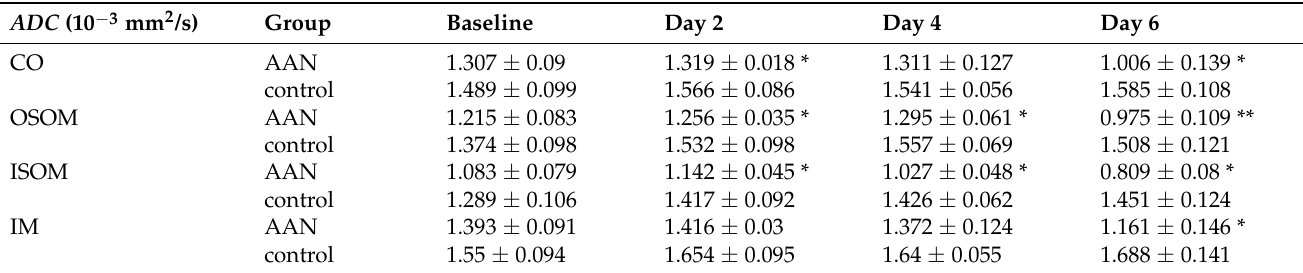
Table 2. Summary of apparent water diffusion coefficients ( ADC ) obtained for the AAN group and for the control group.